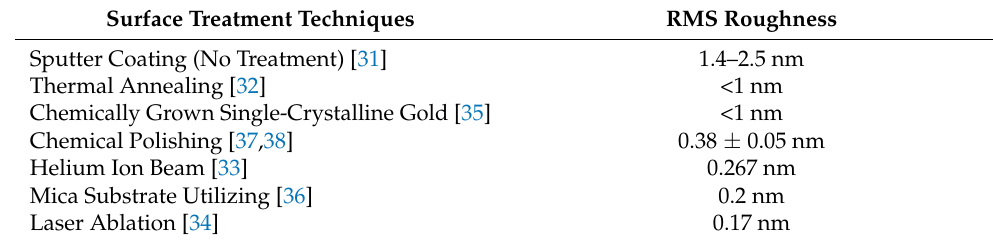
Table 1. The root mean square (RMS) roughness of metal film after different surface treatments. Surface Treatment Techniques RMS Roughness Sputter Coating (No Treatment) [31] 1.4–2.5